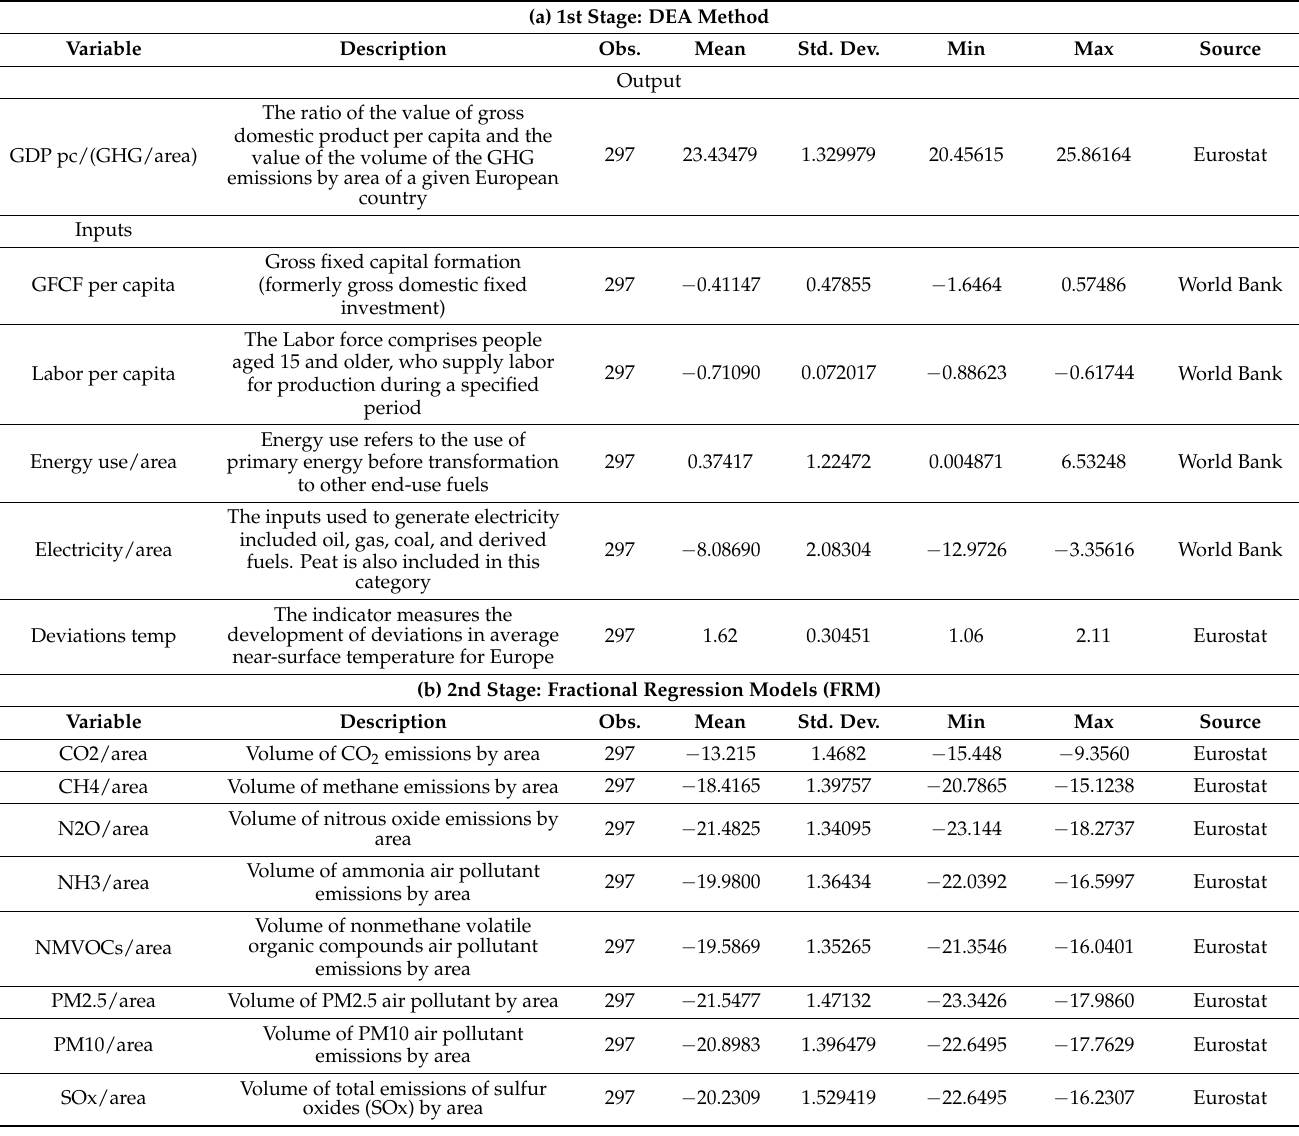
Table 1. Variables descriptions, descriptive statistics, and sources: 2008–2018 period, for 1st stage ( a ) and for second stage ( b ). (a) 1st Stage: DEA